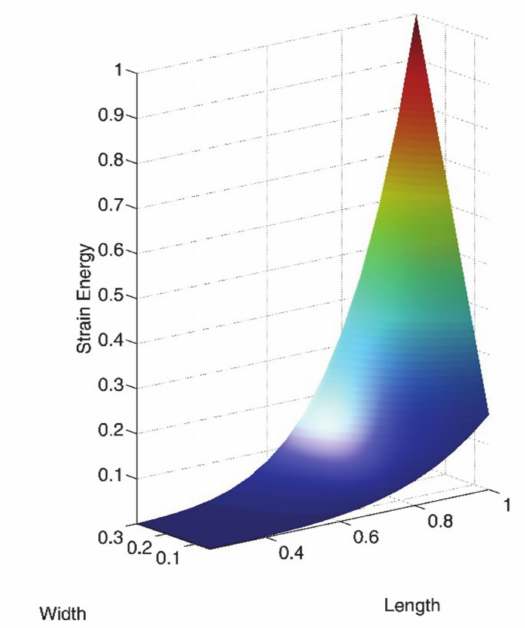
Figure 3. The dependence of MFC-magnet strain energy on the dimensions at the first eigenfrequency of cantilever.